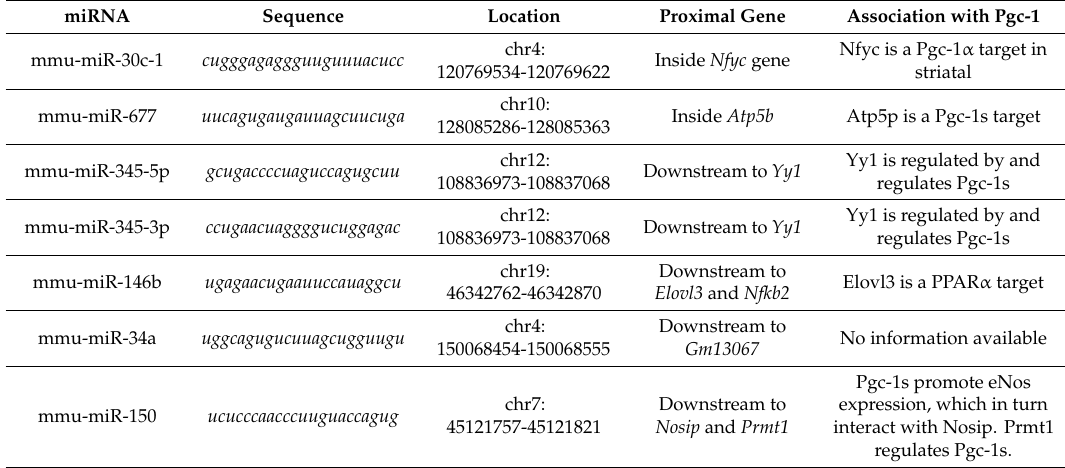
Table 1. Genomic characterization of microRNA upregulated by Pgc-1s. Abbreviations: Nfyc, nuclear transcription factor Y subunit gamma; Atp5b, ATP synthase F1 subunit beta; Yy1, Yin Yang 1; Elovl3, ELOVL fatty acid elongase 3; Nfkb2, nuclear factor kappa B subunit 2; Nosip, nitric oxide synthase interacting protein; Prmt1, protein arginine methyltransferase 1; PPAR α ,